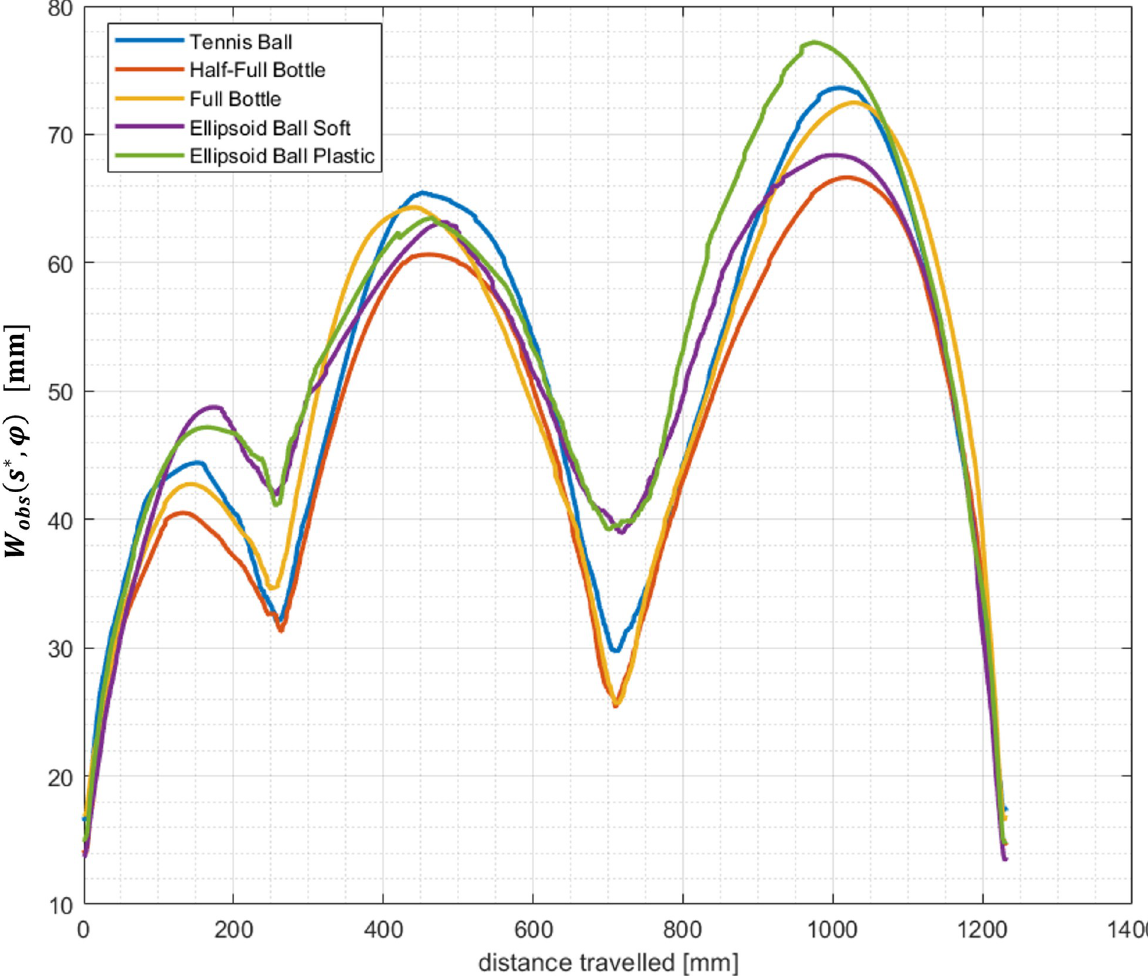
Fig 8. W ( s � , φ ) values averaged over 31 subjects during the object manipulation task. obs